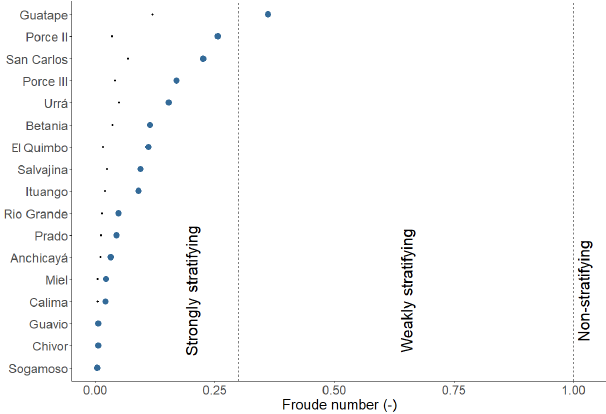
Figure 2. Colombian reservoirs sorted by the densiometric Froude number ( Fr ), which is a function of reservoir depth, length, volume and discharge (Parker et al., 1975). The vertical lines at Fr = 0.3 and Fr = 1.0 indicate the expected boundaries between strongly strat- ifying, weakly stratifying and non-stratifying waterbodies (Orlob, 1983). Small dots represent Fr if the maximum depth (height of dam wall) is used instead of the mean depth, as recommended by Ledec and Quintero (2003). Underlying data were sourced from Autoridad Nacional de Licencias Ambientales and the International Commission on Large Dams (International Commission on Large Dams, 2018) (https://www.icold-cigb.org/, last access: 17 Novem- ber 2020). Five reservoirs from Table 1 are excluded because of missing discharge data.